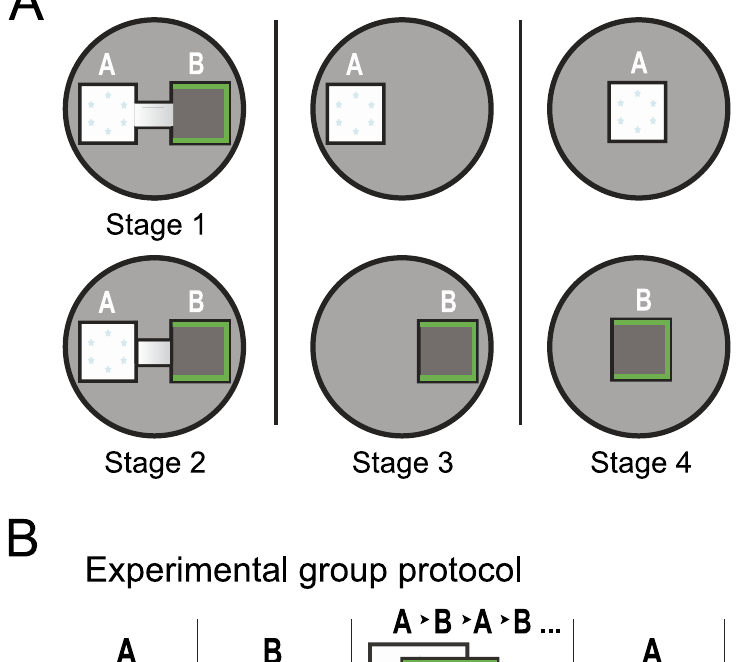
alley between the arenas was closed and the enclosures were presented separately. In the third phase (single box/ two locations) we replaced the whole apparatus with a single box that was equipped with both sets of lights and presented at the original locations. Finally, in the fourth stage (single box/one location) the same single box was presented in the common location in the center of the recording chamber independently of the cues lit. Across phases 2 to 4 the rats experienced three 10-min sessions in each of the two environment identities. The order of environment presentation was randomly chosen from four predefined schemes (ABBAAB, ABABBA, BAABBA and BABAAB). Across all phases the animals rested for 20-min between the sessions in a cushioned pot on a pedestal located outside the curtains. On the testing day (Fig. 1B), both groups were first exposed to each environment for 10 min (PRE sessions). Then, the experimental group received one teleportation session. Each rat was introduced into the arena with one set of lights on. After 60–90 s of free exploration the light cues were switched to the other set, instantane- ously changing the visual discriminants of the environment. The light switching (teleportation trial) was repeated